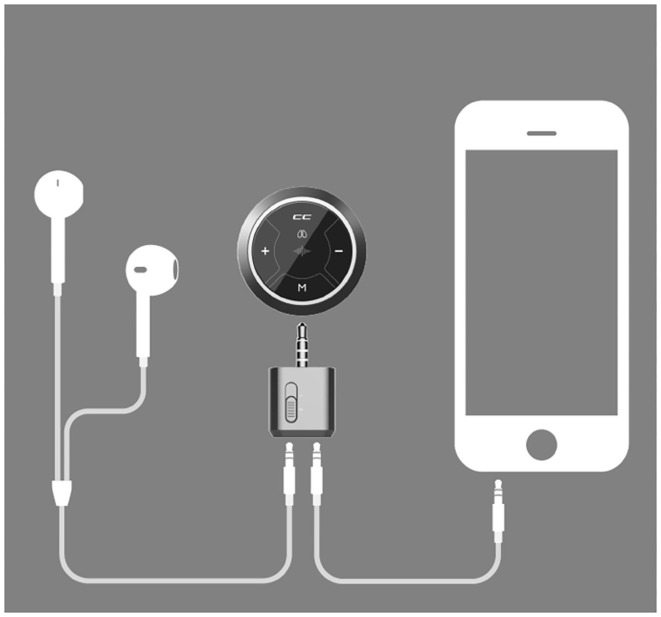
The electronic stethoscope connects to the smartphone and uploads the lung auscultation recordings to the cloud.